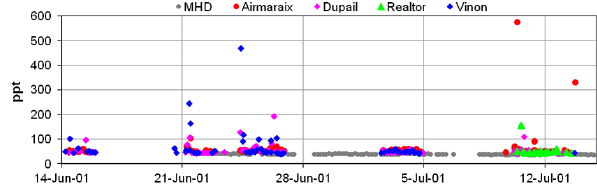
Figure 9. MCF mixing ratios measured at four sites in the vicinity of the Marseille urban area. Details on the sampling campaign can be found in Coll et al. (2010). The grey dots represent the MHD time